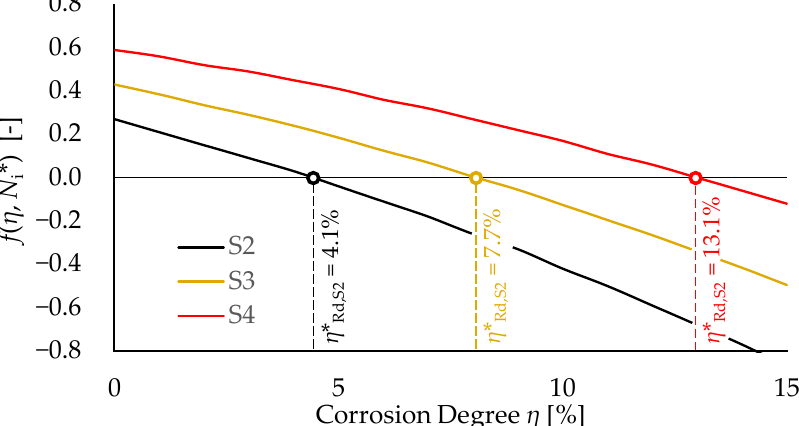
Figure 9. Trend of f ( η * Rd , N * Si ) for increasing values of maximum corrosion degree for each consid- ered corroded specimen ( S2 -to- S4 ).